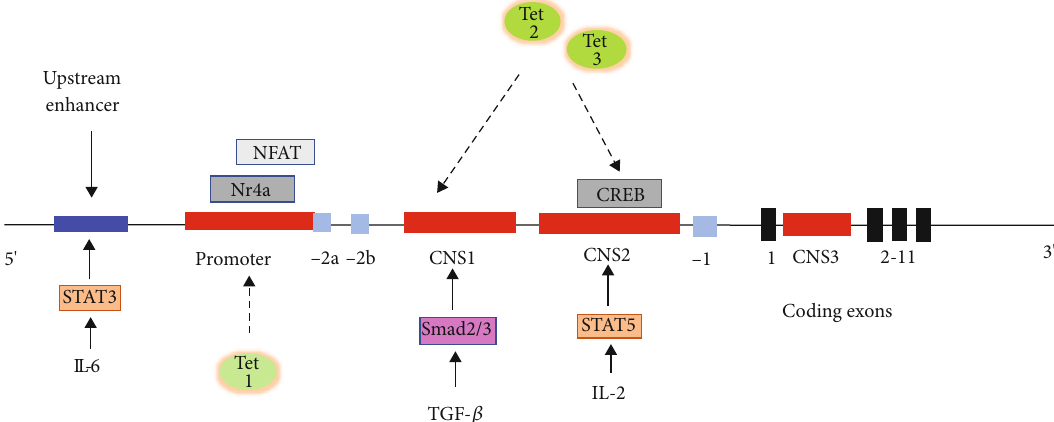
Figure 2: The structure of the Foxp3 gene. Red bars represent four important cis-regulatory elements of the Foxp3 gene. Light-blue and black bars represent three noncoding and 11 coding exons. Of the three enhancers, CNS2 is important for stable Foxp3 expression. Cytokines (e.g., IL-2, IL-6, and TGF- β ) can act on related regions to regulate Foxp3 expression. Among the three Tet enzymes, Tet1 acts on promoters and transcription start sites. Tet2 mainly acts on gene bodies, whereas Tet2 and Tet3 work together to regulate CNS2 and CNS3 demethylation, as well as other regulatory